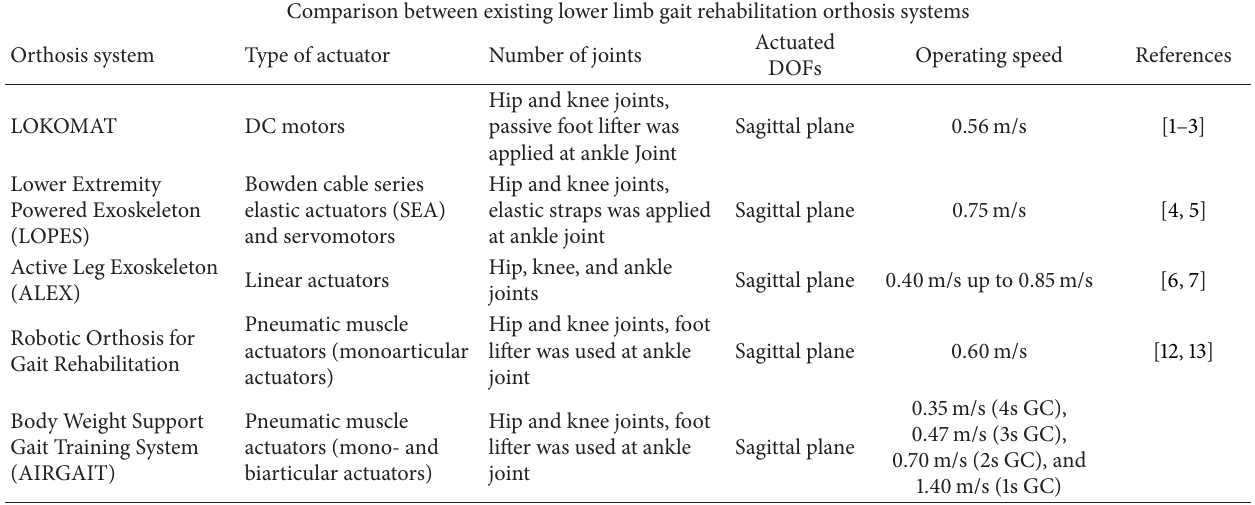
Table 1: Existing lower limb gait rehabilitation orthosis systems